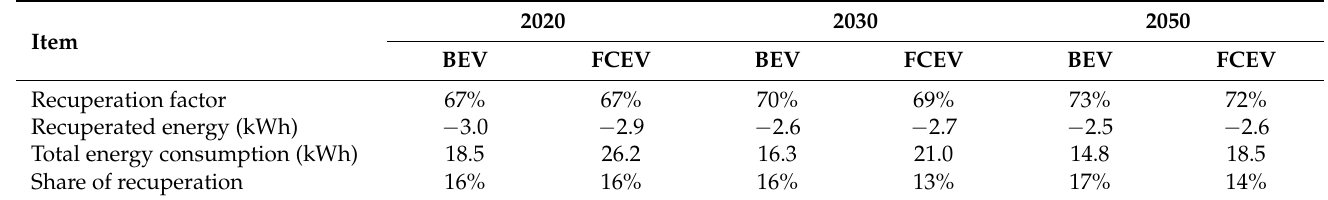
Table 15. Reduction in consumption by recuperation from 2020 to 2050 (large passenger car, WLTP triple-mixed cycle, transition season, and hilly